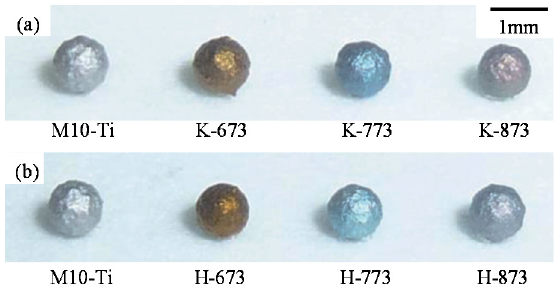
Figure 54. Photograph of the samples.